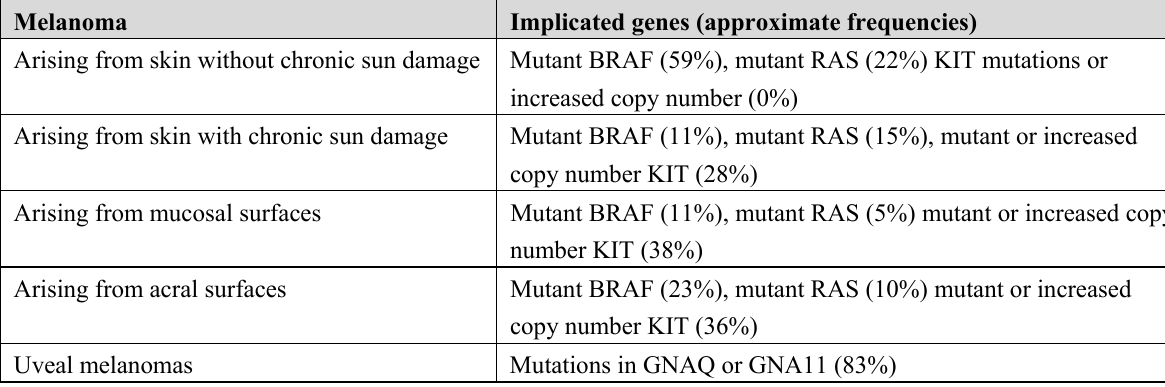
Table 3. Major molecular subtypes of melanoma. Source data references